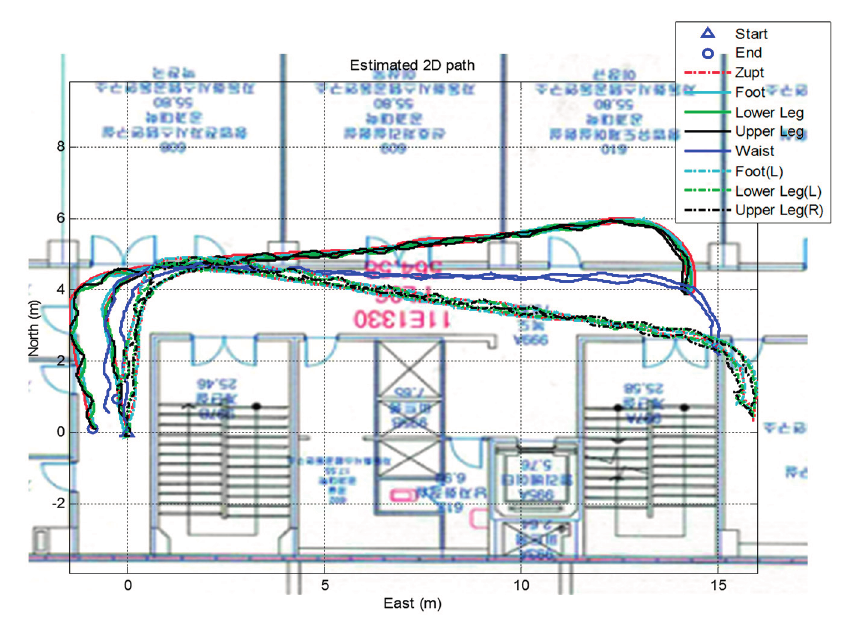
Figure 12. Result of the proposed algorithm compared with feet position using the ZUPT